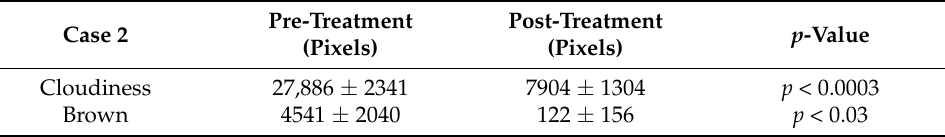
Table 2. In Case 2, the cloudiness and brown areas from the pre-treatment (before applications) and post-treatment (after seven applications) images were measured as pixels by digital image analysis. The analysis was performed three times, and the mean and standard deviations of the measurements were calculated (mean ± SD). The significance of the differences in areas before and after treatment was evaluated with p -values by t